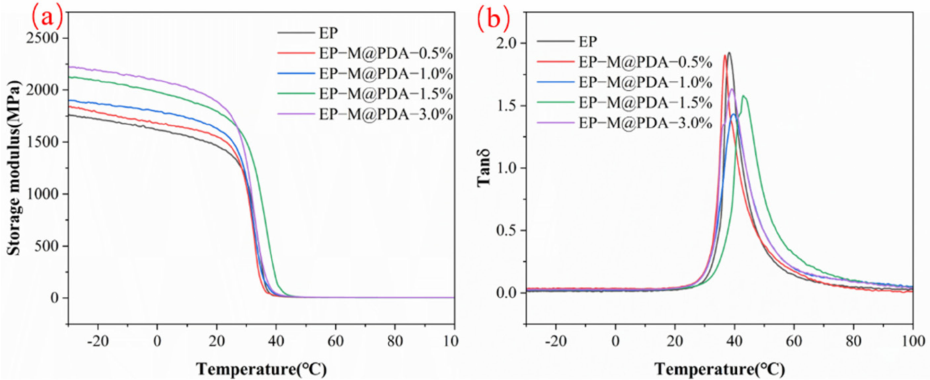
Figure 8. ( a ) Storage modulus vs. temperature curves. ( b ) Tan δ vs temperature curves.